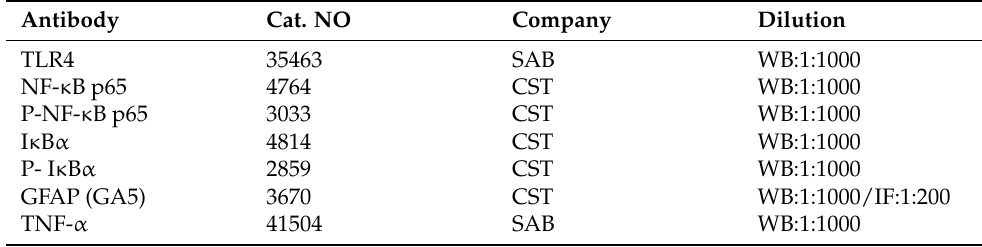
Table 1. Antibody information. Antibody Cat.